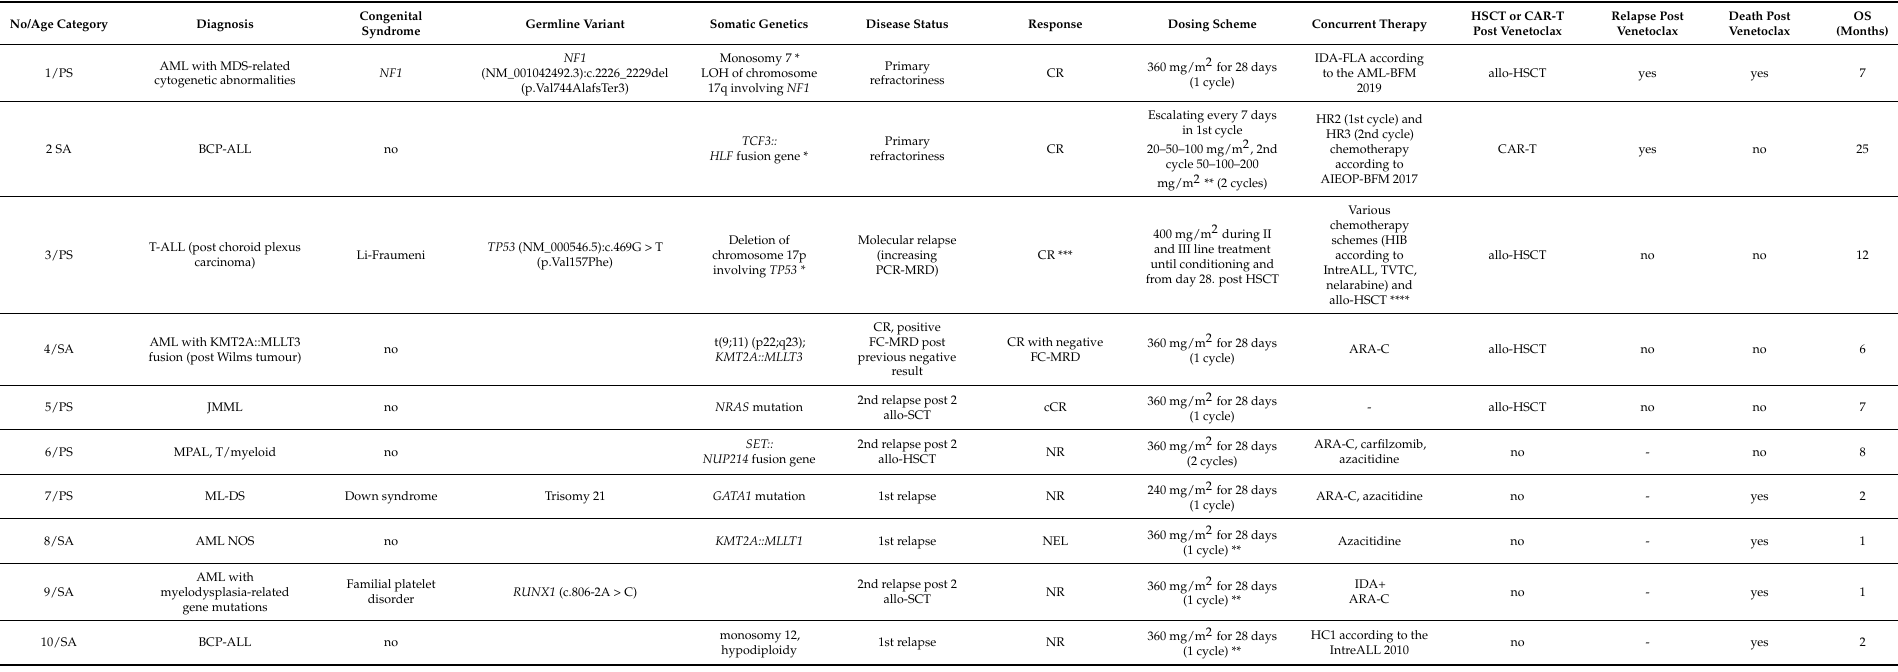
Table 1. Characteristic of the study